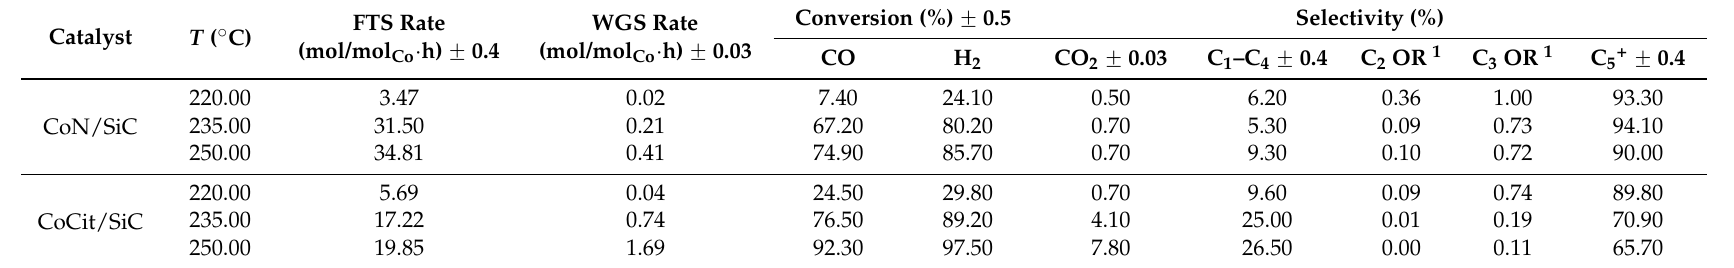
Table 2. Influence of cobalt precursor on FTS: 20 bar; 6000 Ncm 3 /g ¨ h; H 2 /CO: 1.8.